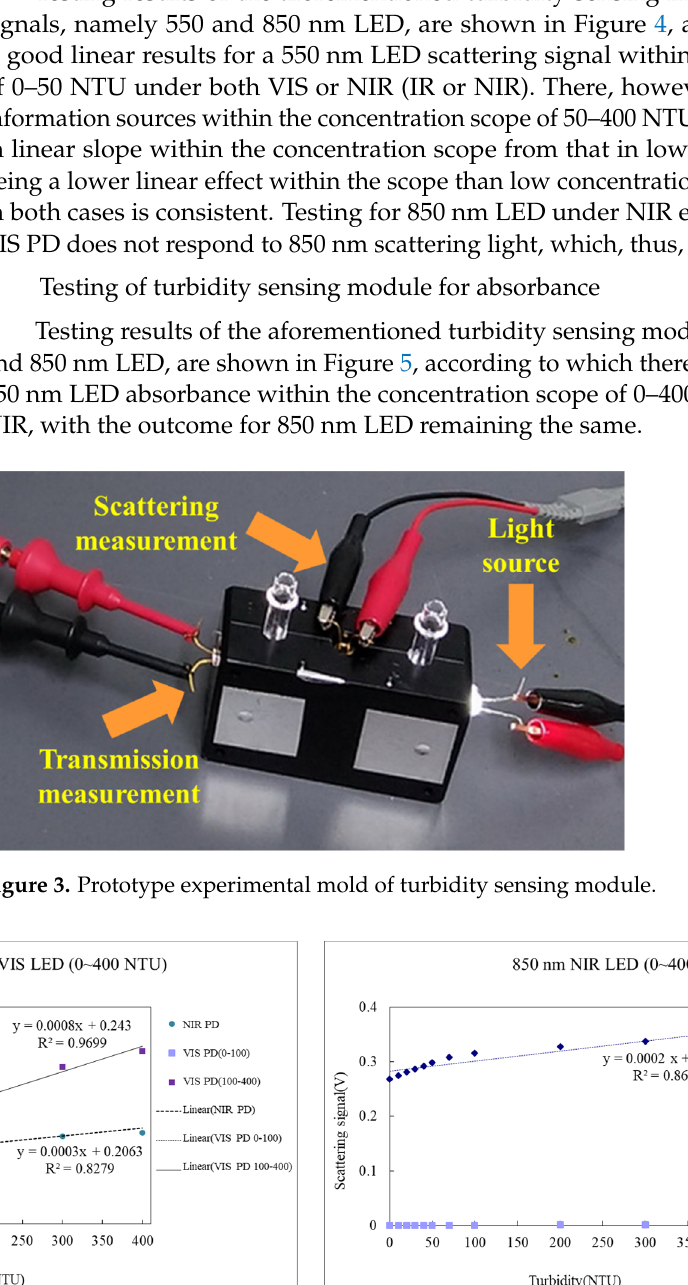
( b ) Figure 5. Results of testing of turbidity sensing modules for absorbance. ( a ) 550 nm LED. ( b ) 850 nm LED. 3.3.2. Establishment of Algorithm for Turbidity Sensing Modules Based on the aforementioned results concerning turbidity optical characteristics, the team establishes a turbidity prediction module for estimating the water sample’s turbidity. Five algorithm models for the turbidity prediction module were established based on measurement results from scattering light intensity, degree of transmission and reference lighting-source intensity with every lighting source. The five algorithm models were de- scribed as follows: 1.